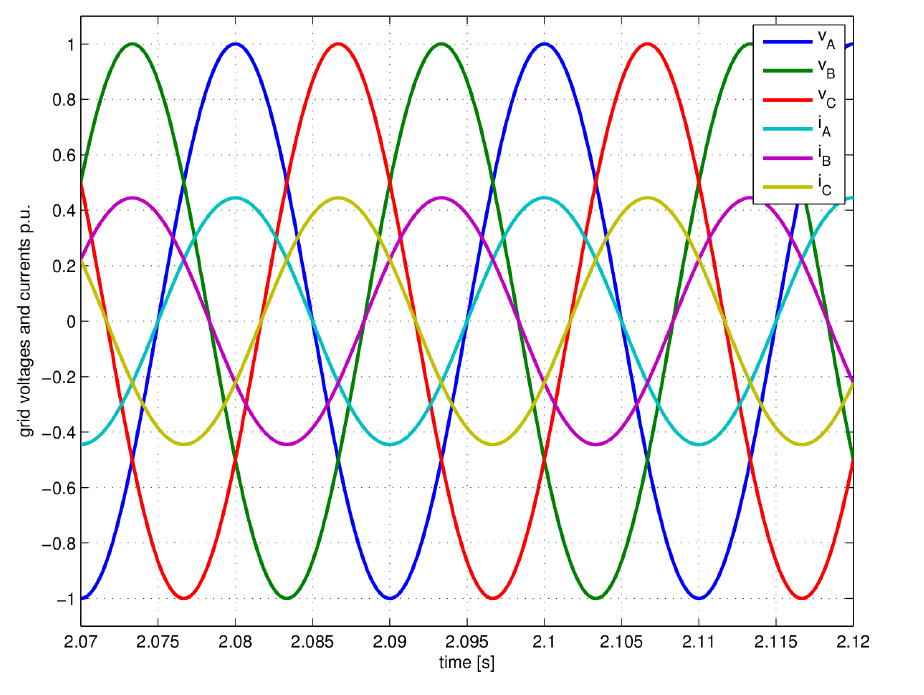
Figure 7. Grid Voltages and Currents (in p.u. system) at steady state for zero reactive power delivered.